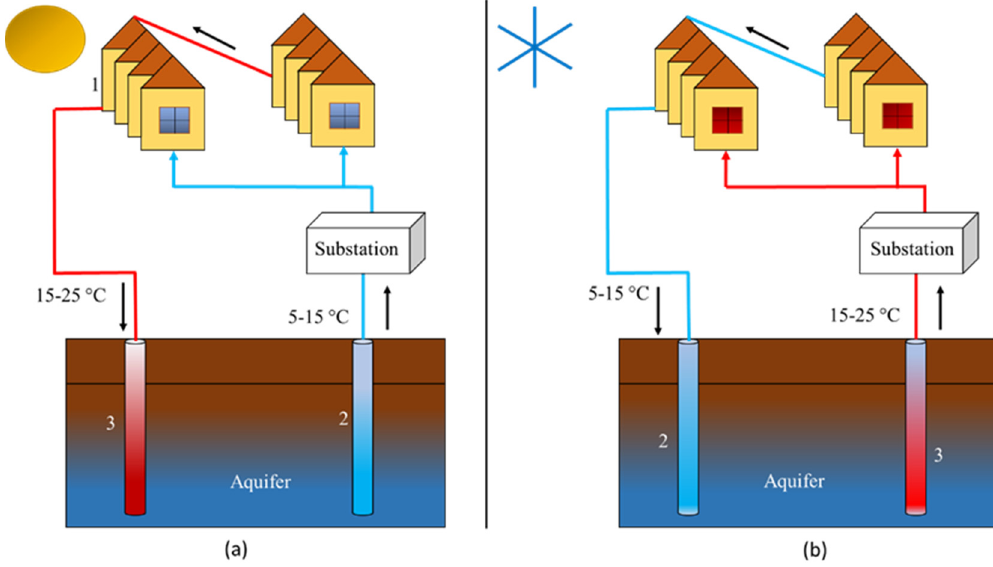
Figure 12. Aquifer thermal energy storage in summer ( a ) and winter ( b ). 1—DH users, 2—cold well, 3—warm well.